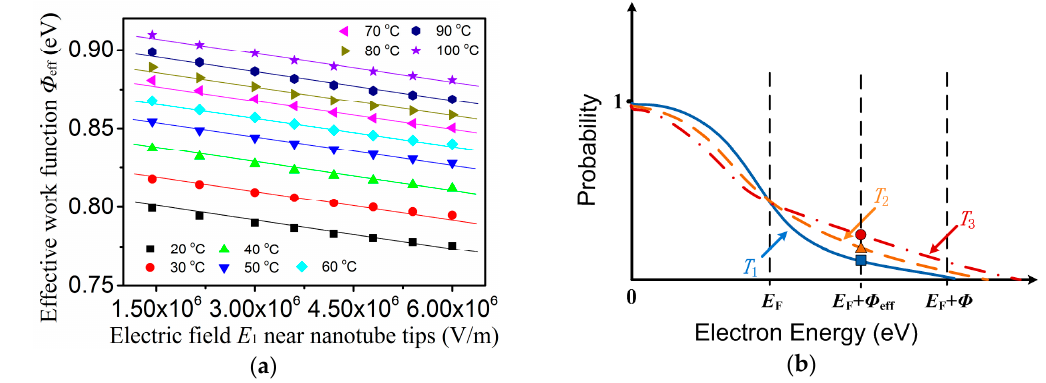
Figure 3. ( a ) The effects of the E 1 on Φ eff ; ( b ) The effect of temperature on the probability of an electron gaining energy.